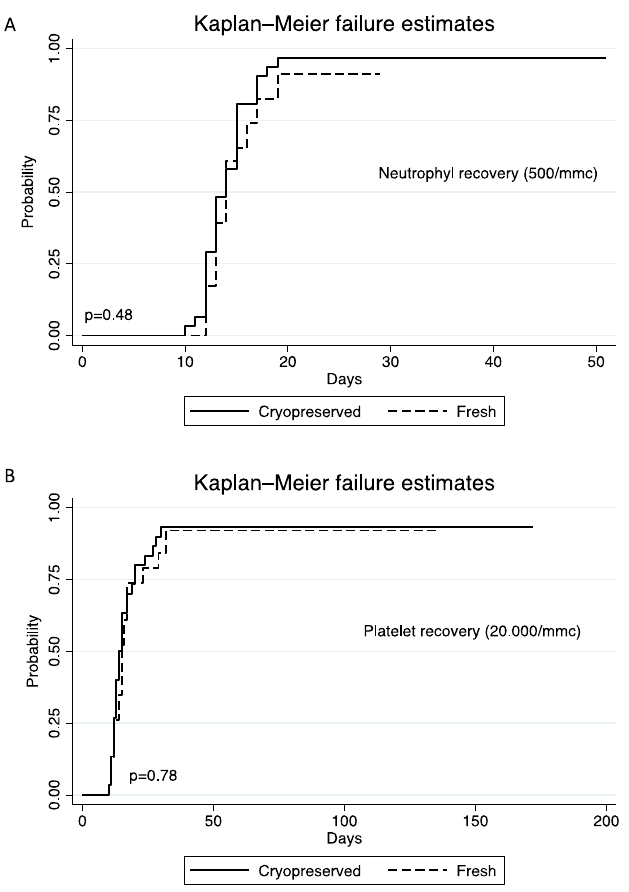
Figure 1. Cumulative incidence of neutrophil ( A ) and platelet ( B ) engraftment in Cryo and Fresh groups.